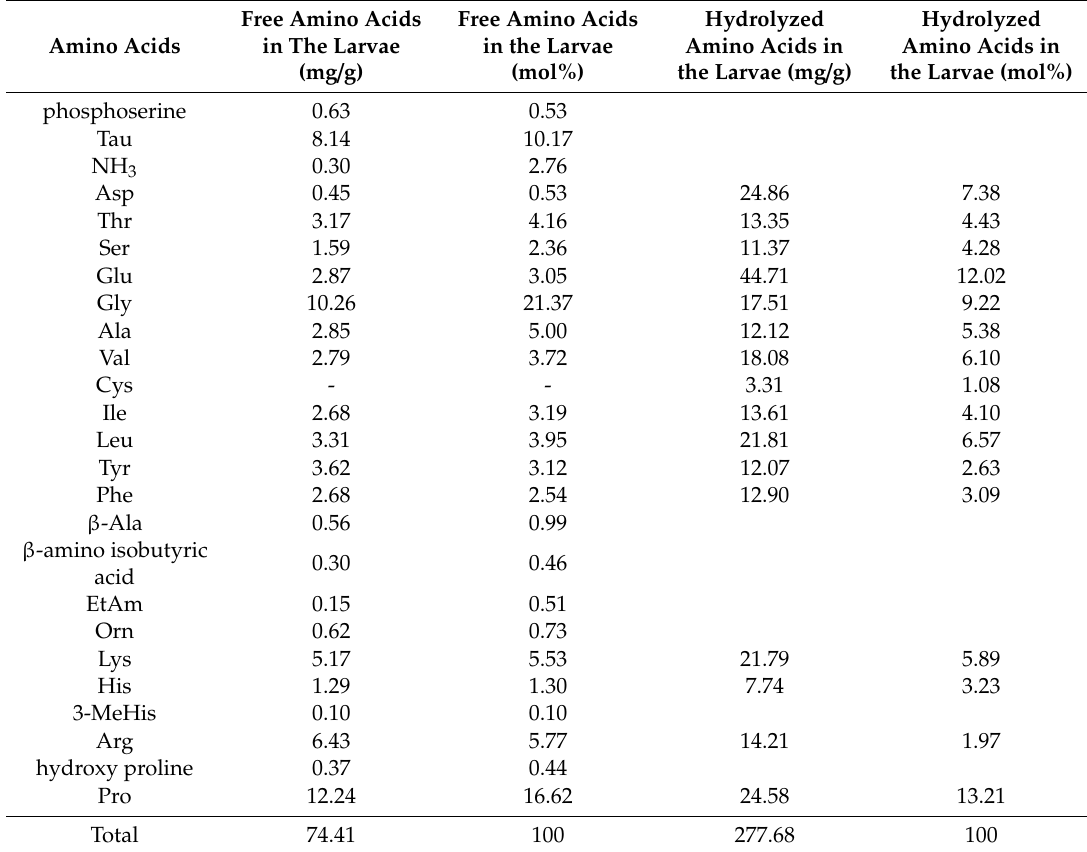
Table 5. Amino acids composition in the